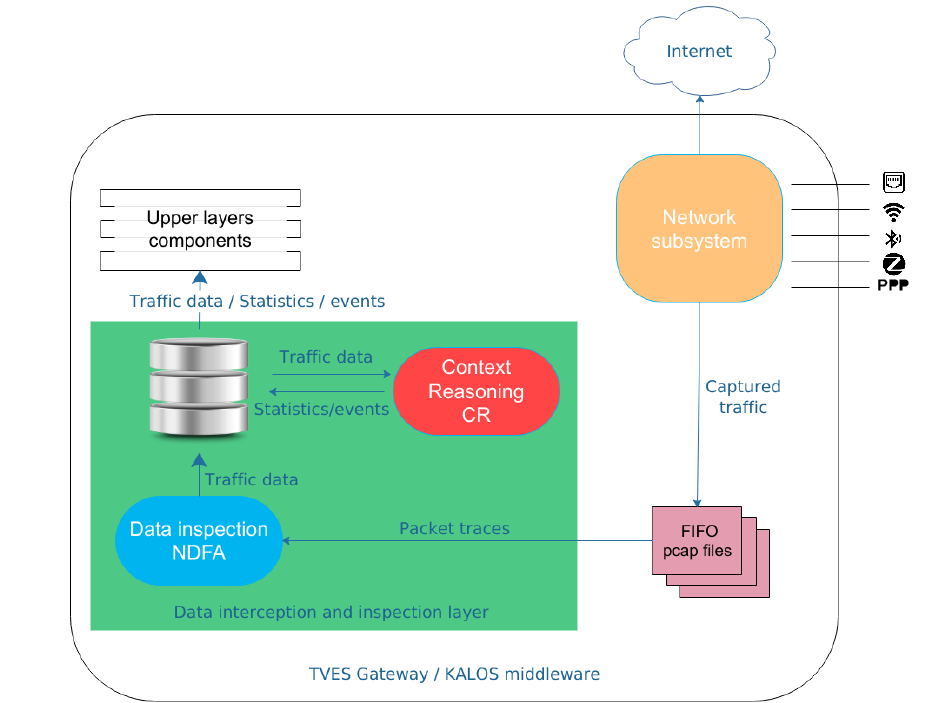
Figure 1. NDFA role in